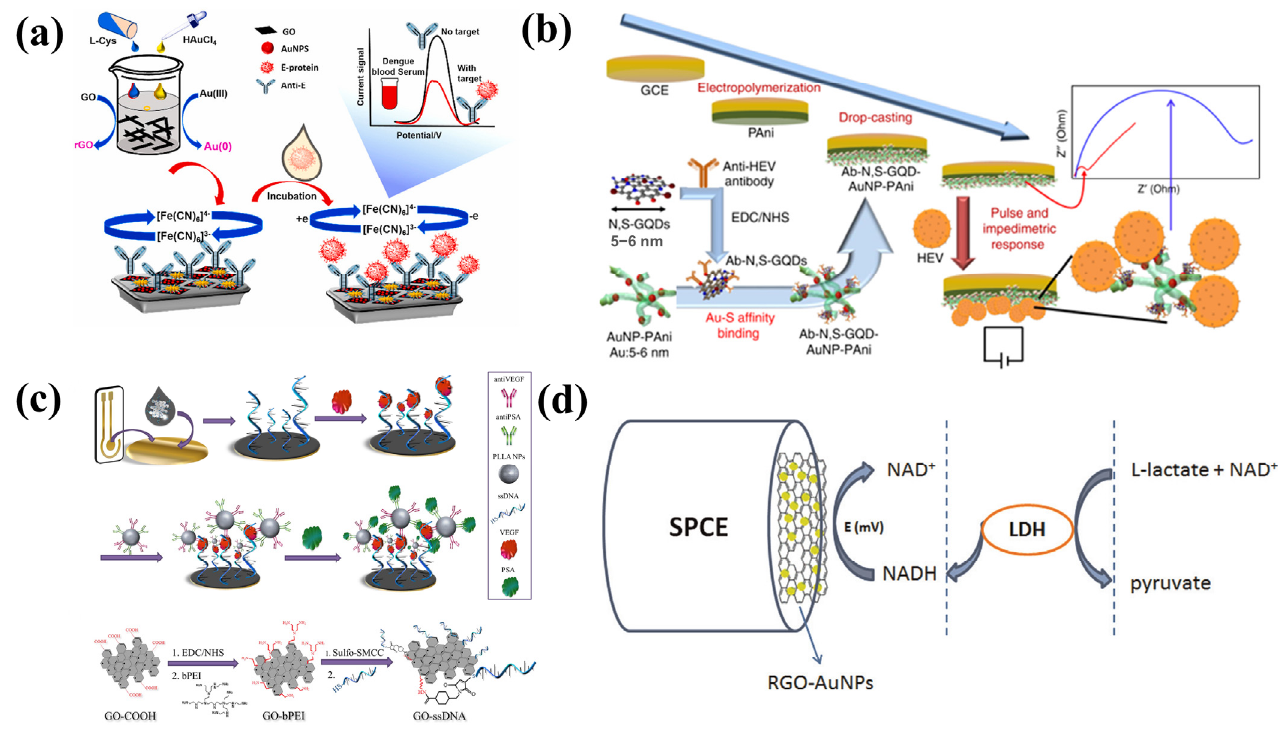
Figure 4. ( a ) An electrochemical immunosensor platform was created for the detection of dengue virus type E-proteins using in situ reduced and modified gold nanoparticle-adorned heteroatom- doped reduced graphene oxides nanocomposites (DENV–E protein). Reproduced with permission from [63]. ( b ) Schematic illustration of the pulse-induced impedimetric sensing of HEV using the Ab-N,S-GQDs@AuNP-PAni nanocomposite-loaded sensor electrode. Reproduced with permission from [64]. ( c ) Process flow diagram for creating GO-ssDNA. With permission, reproduced from [65]. ( d ) Schematic illustration of the LDH/rGO-AuNPs/operation, SPCE biosensors. Reprinted with permission from [66].